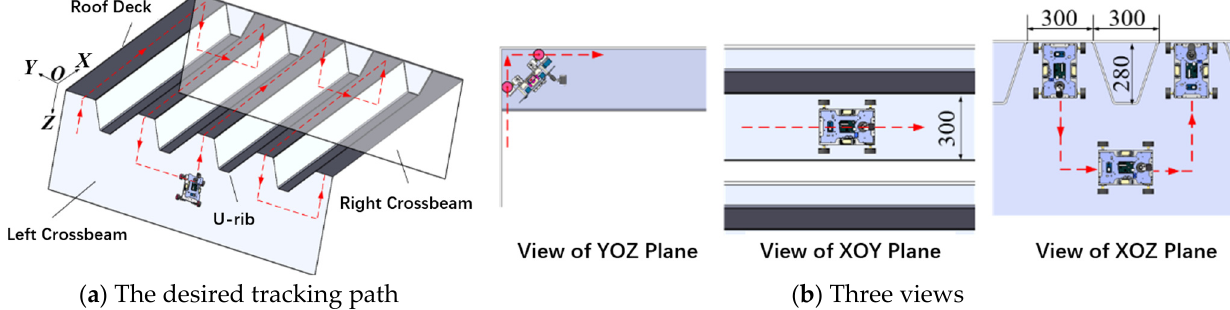
Figure 4. Schematic of the robot inspecting the SBG.